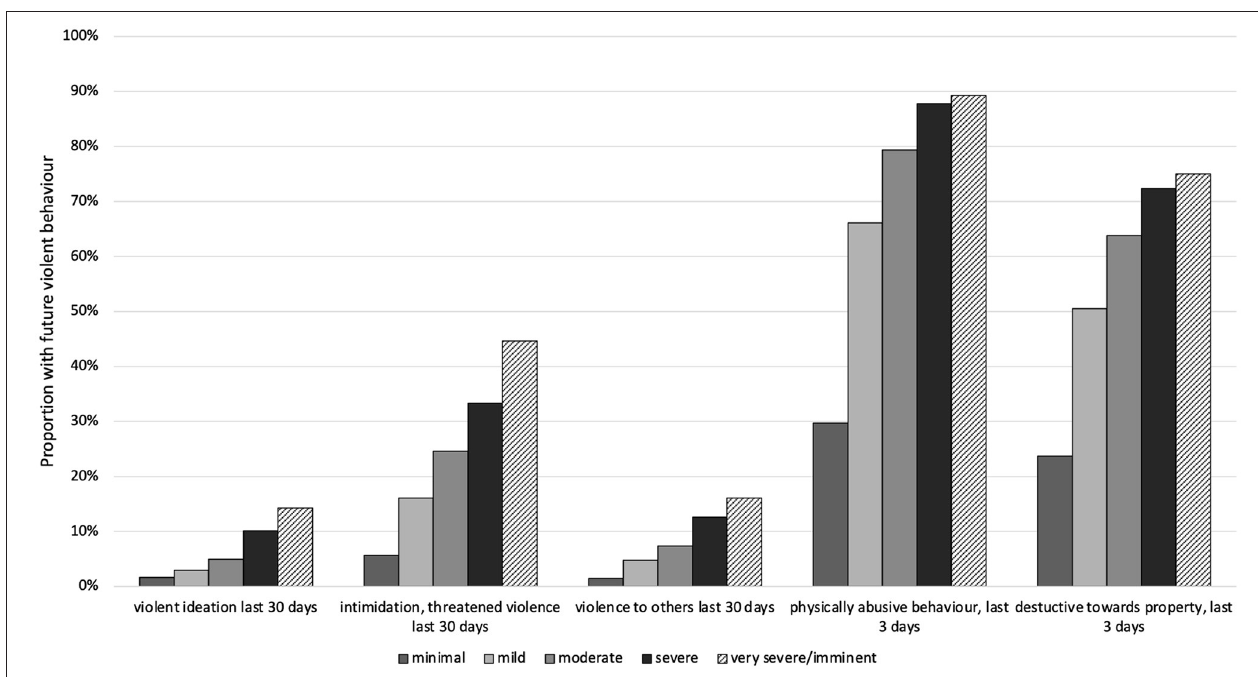
FIGURE 2 | Longitudinal analysis: High risk for future violent behaviour by subjective assessor rating of “danger to others” at baseline ( N = 6,608).